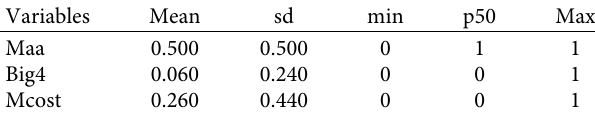
Table 9: Descriptive statistics of Maa, Big4, and Mcost.